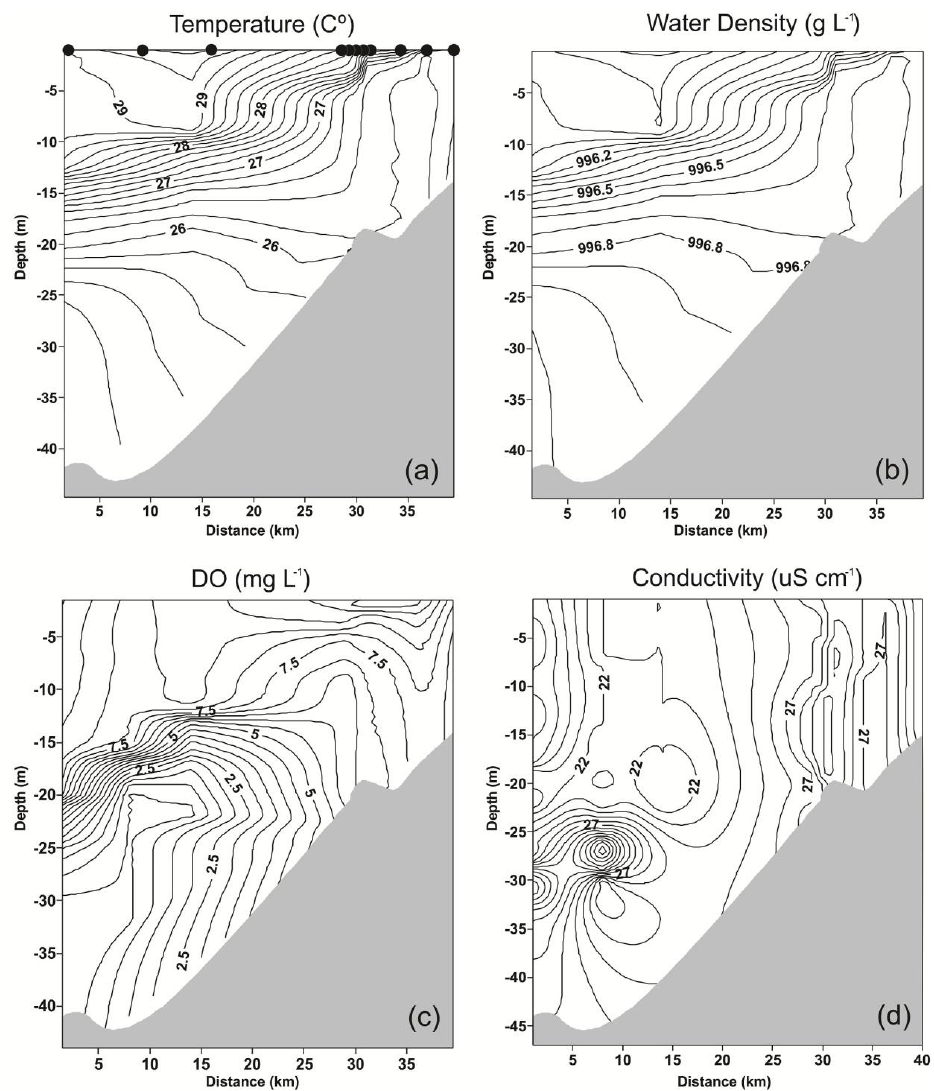
Figure 7: Isopleths of the (a) water temperature, (b) density, (c) dissolved oxygen and (d) conductivity in Manso Reservoir during March (wet season). The dots at top of temperature panel correspond to longitudinal transects.